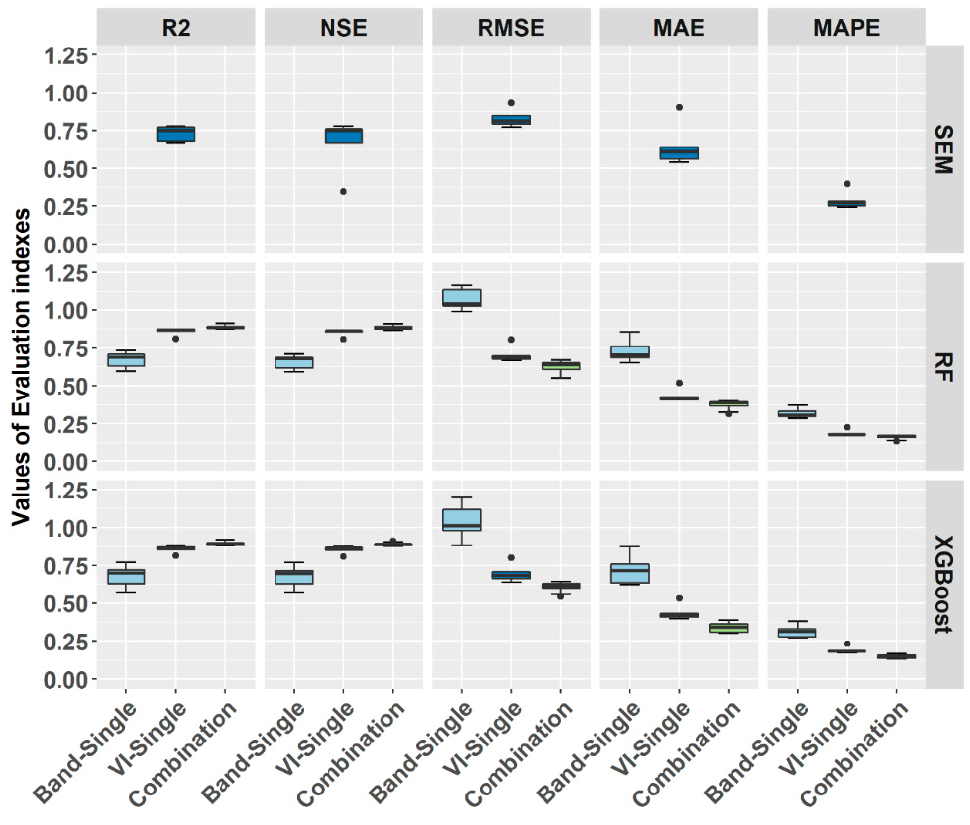
Figure 13. Boxplot for the estimation accuracy of leaf area index (LAI) with band, vegetation index (VI), and their combinations as input variables. The horizontal line in the box is the median, the ends of the box are the lower hinge (25th percentile, Q1) and the upper hinge (75th percentile, Q3), and the whiskers extend to 1.5× (Q3–Q1), beyond which outliers are indicated by a black dot.